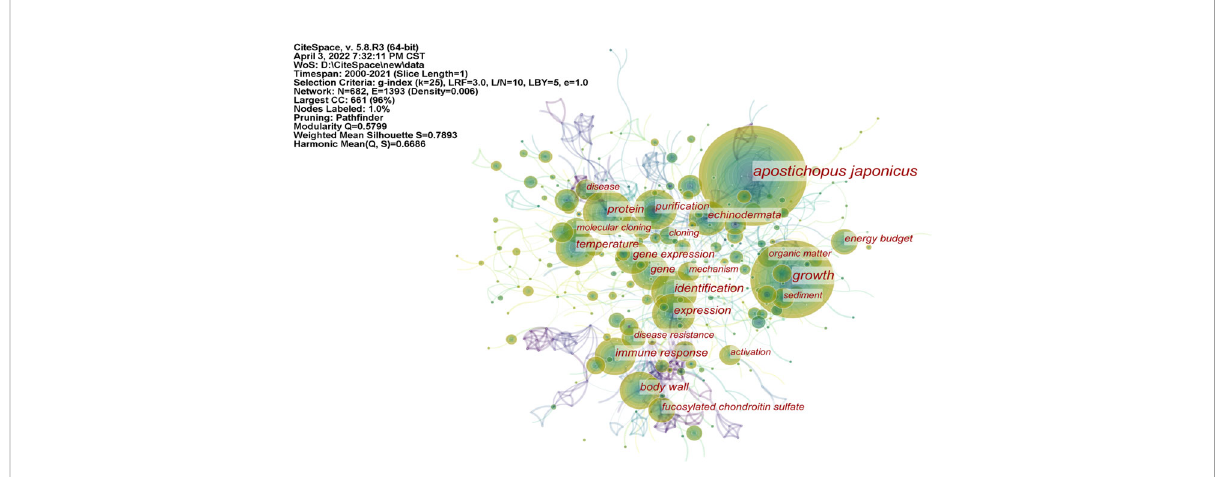
FIGURE 3 The map of keyword co-occurrence in articles related to the research of Apostichopus japonicus published from 2000 to